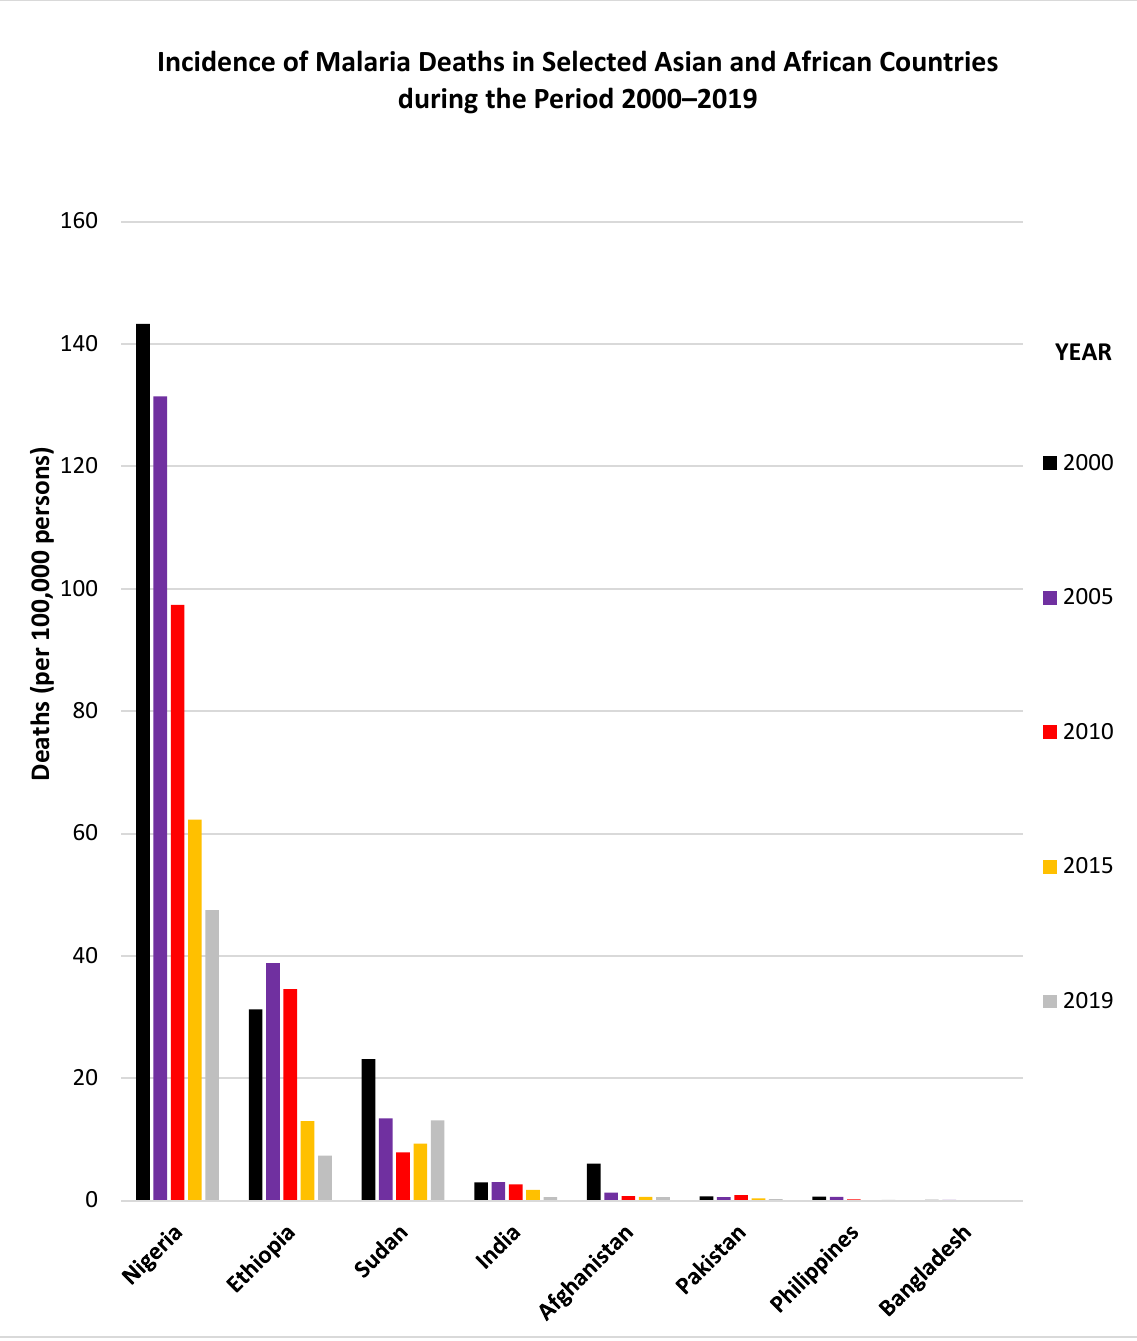
Figure 4. Incidence of malaria deaths in selected Asian and African countries during the period 2000–2019. The graphs were made using data adopted from WHO, World Malaria Reports, 2019 and 2020 and the Malaria Atlas Project 2019.